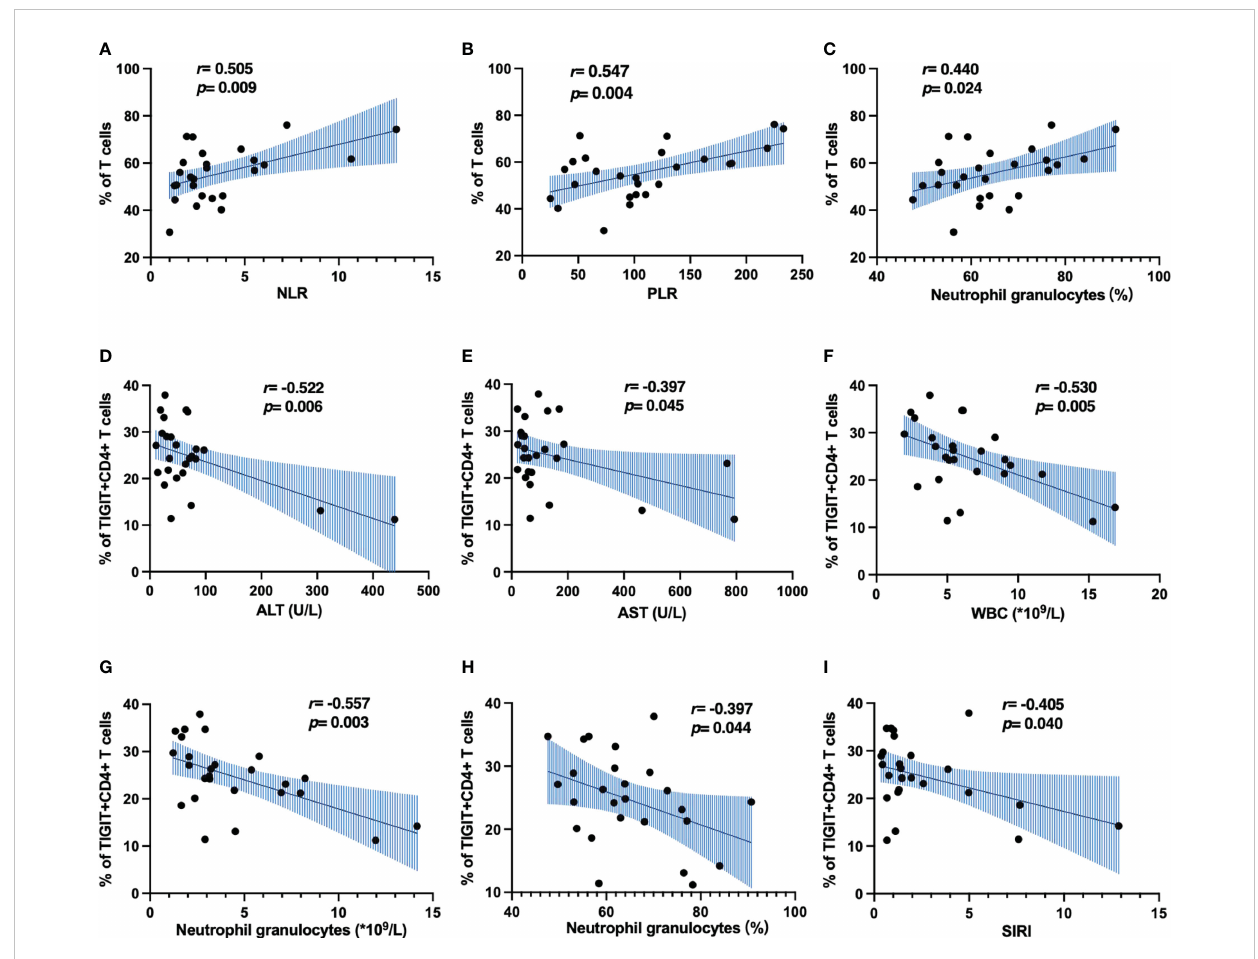
FIGURE 6 Correlation analysis of immune cell phenotype and clinical indicators in patients with HBV-HCC. (A – C) The correlation of CD3 + T cells and in fl ammatory markers. (D – I) The correlation of TIGIT + CD4 + T cells and in fl ammatory